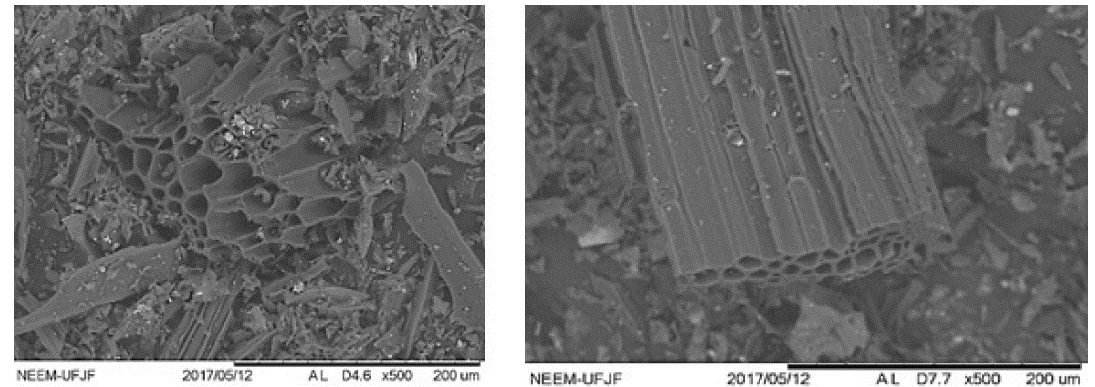
Figure 5. SEM images of elephant grass